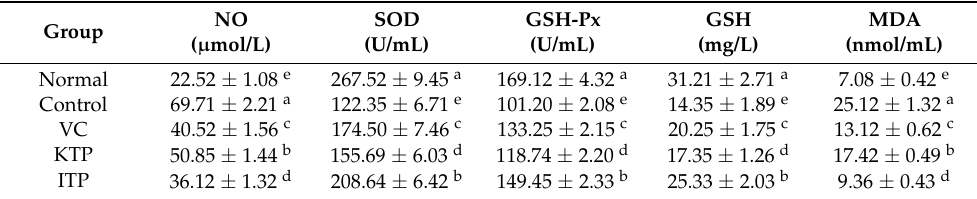
Table 2. Activities of NO, SOD, GSH-Px, GSH and MDA in serum of mice.